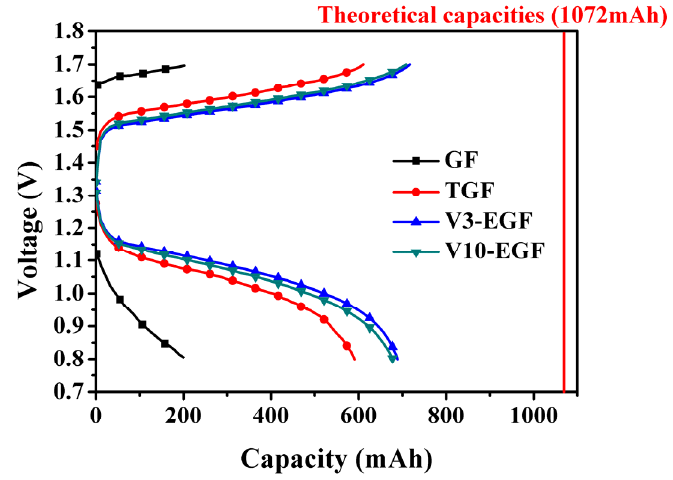
Figure 8. Charge–discharge curves at 150 mA cm − 2 (3rd cycle) of ( a ) GF, ( b ) TGF, ( c ) V3-EGF, and ( d ) V10-EGF.